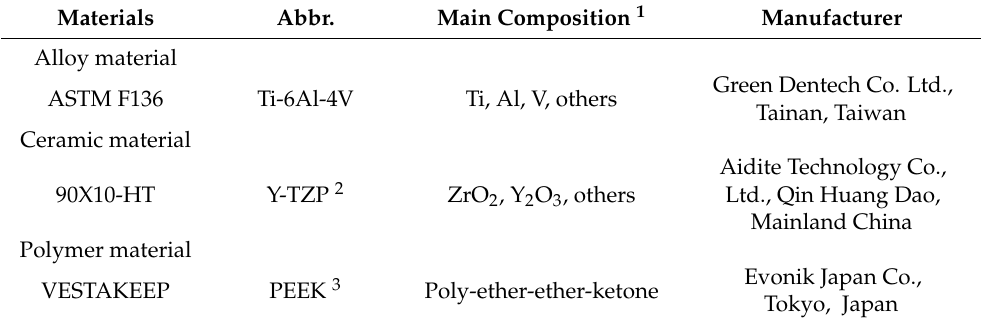
Figure 1. The chemical structure of PEEK. Table 1. Dental materials used in this study.